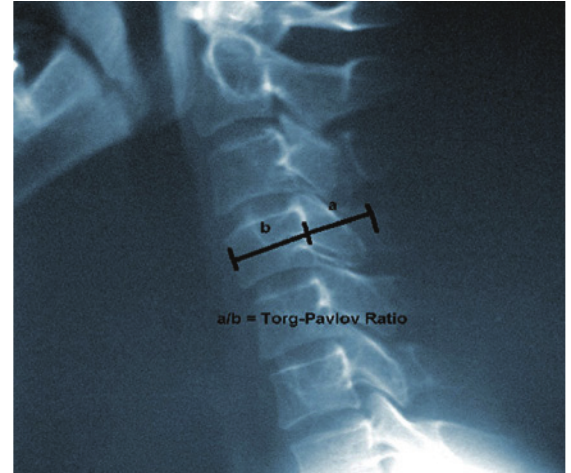
Figure 1: The Torg’s ratio (a/b) is a comparison between the sagittal diameter of the spinal canal (a) and the sagittal diameter of the vertebral body (b).